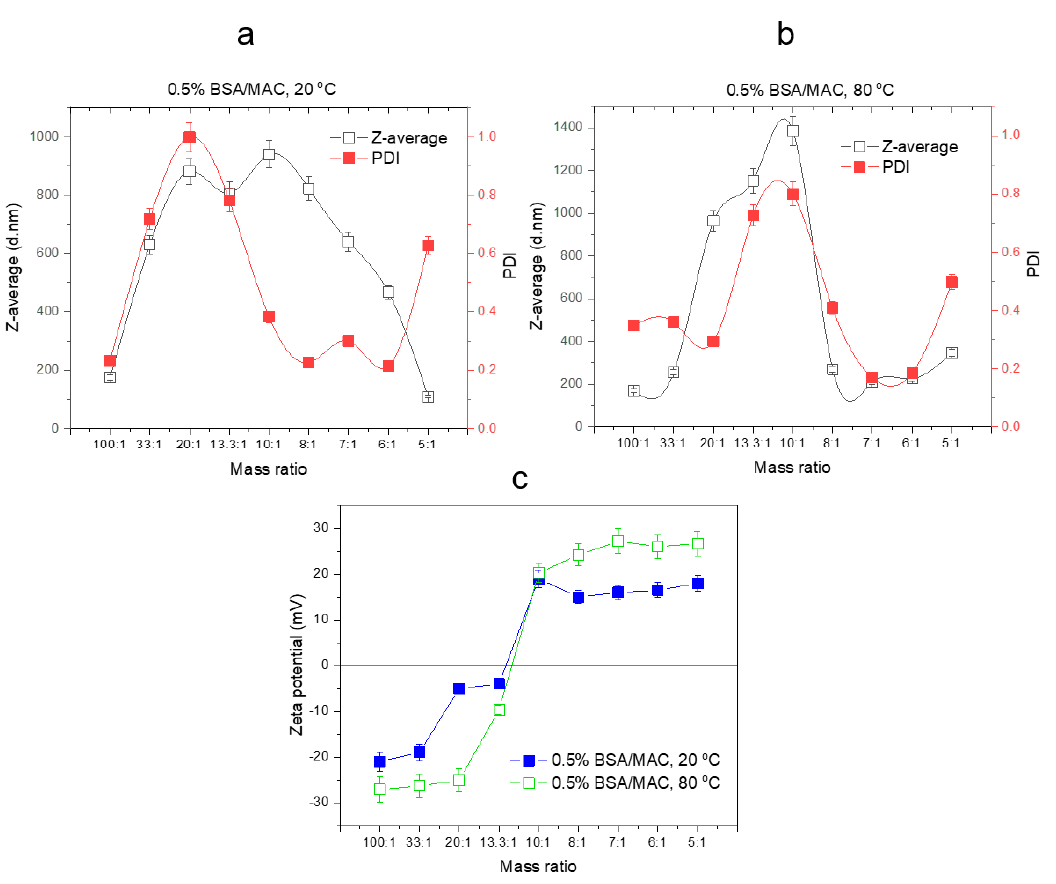
Figure 3. DLS ( a , b ) and zeta potential ( c ) evolution of the nanogels in relation to the synthesis conditions (BSA and MAC at 0.5% w/v ).